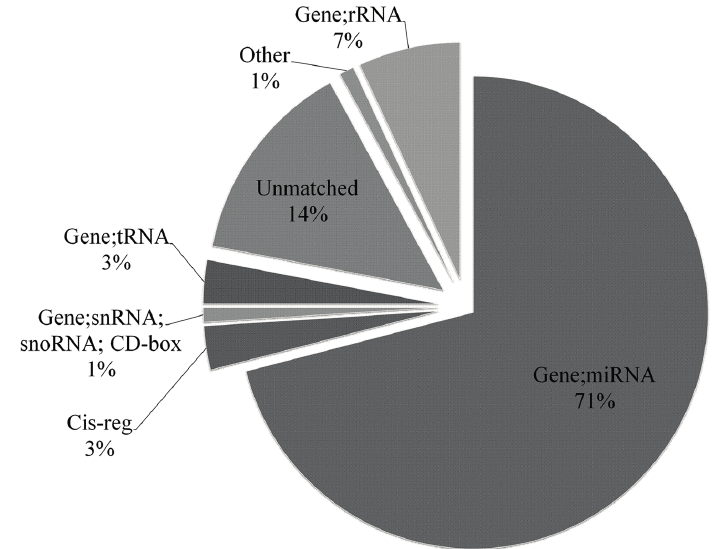
Figure 3. Frequency of unique small RNA distribution among the different categories. The unique sequences were subjected to searches for the types and numbers of sRNA using the Rfam databases (rRNA; tRNA; sn/snoRNA; miRNAs; other noncoding